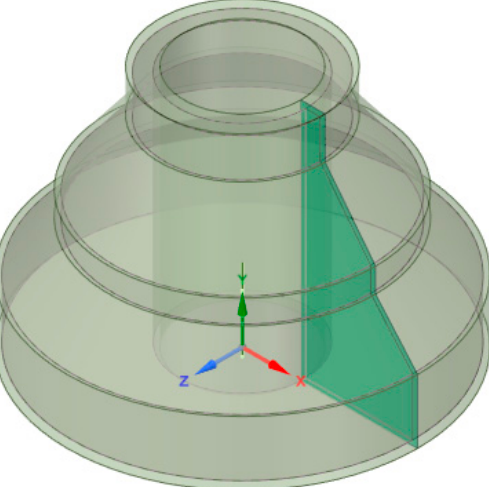
Figure 2. The 3D geometry and 2D axisymmetric section.